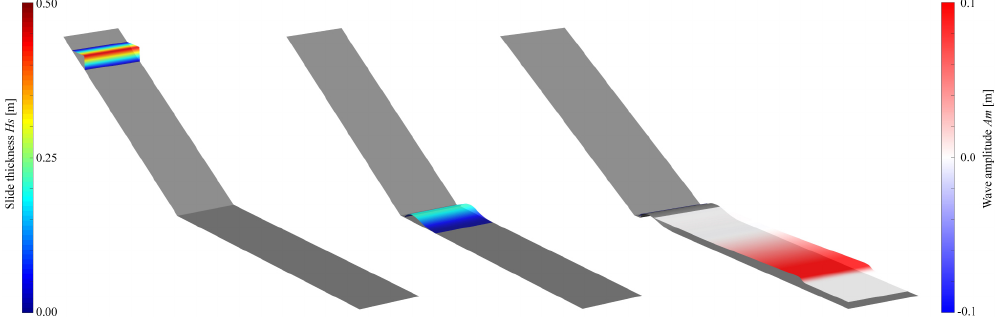
Figure 3. Numerical representation in 2.5D of the near-field section of the flume with water depth h = 0.2: (left) initial condition of the landslide (water level not displayed), (centre) landslide deposit (water level not displayed) and (right) landslide deposit (not coloured) with the generated wave.